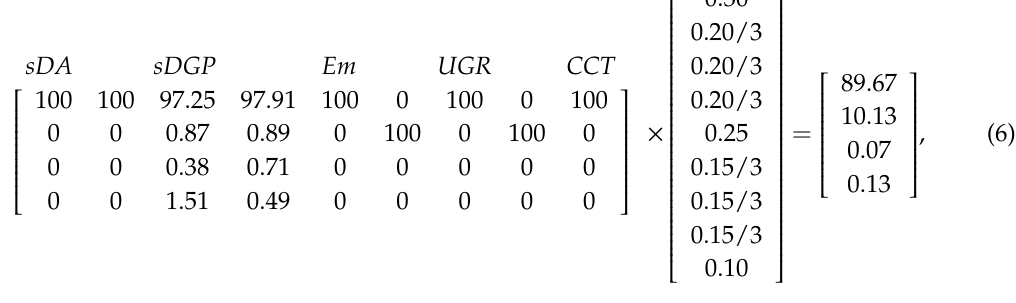
Figure 6. Distribution of illuminance in Bedroom 2: ( a ) plan and ( b ) perspective view.